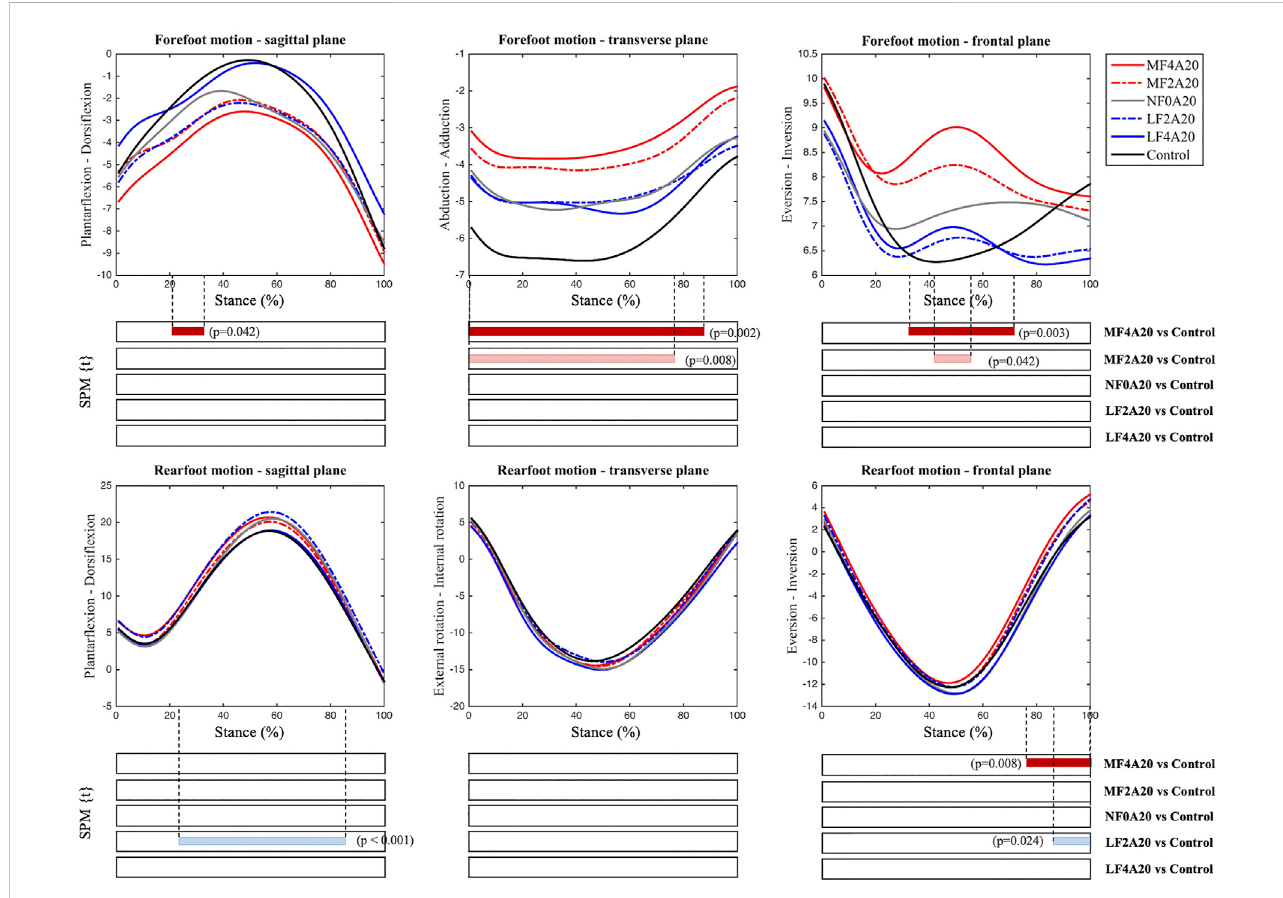
FIGURE 4 Average foot kinematic traces ( ° ) of different FOs with an arch support height of 20 mm and the control during the stance phase of jogging. Shaded bars indicate signi fi cant differences ( p < 0.05) between each FO and the control using SPM.